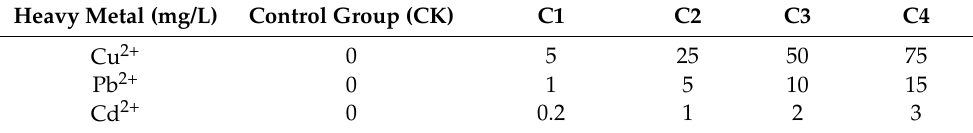
Table 1. Heavy metal concentrations in artificial sewage prepared from 1/2 Hoagland’s nutrient solution. Heavy Metal